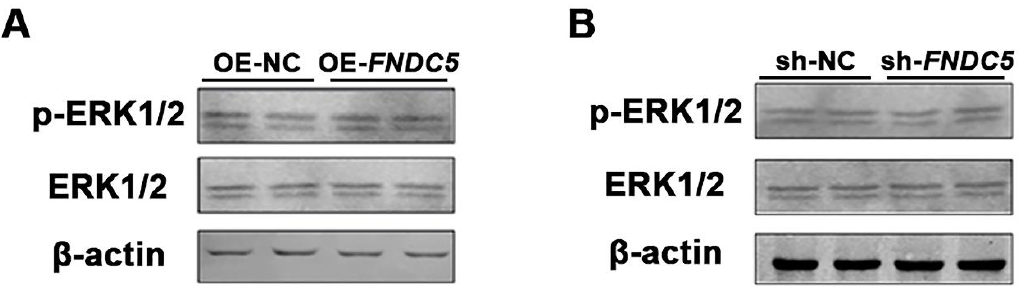
Figure 4. Effect of FNDC5 on phosphorylation of ERK1/2. ( A , B ) Western blotting of ERK1/2 and phosphorylated ERK1/2 after transfecting the FNDC5 overexpression and interference vectors in porcine preadipocytes. β -actin was used as the internal reference protein.